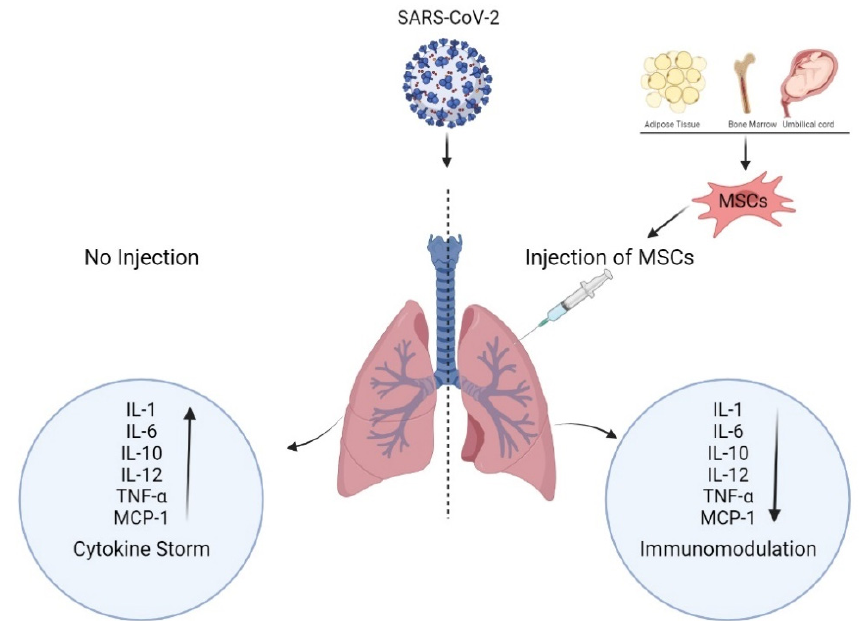
Figure 2. Effects of mesenchymal stem cells (MSCs) therapy on the patients of COVID-19.